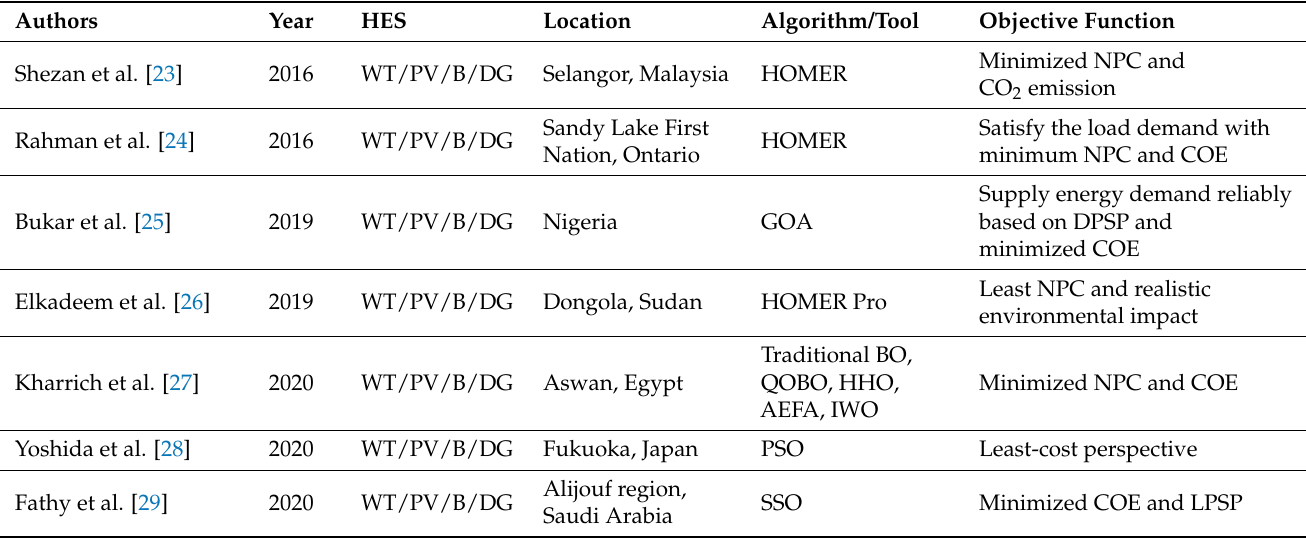
Table 1. Summary of previous works with different objective functions and